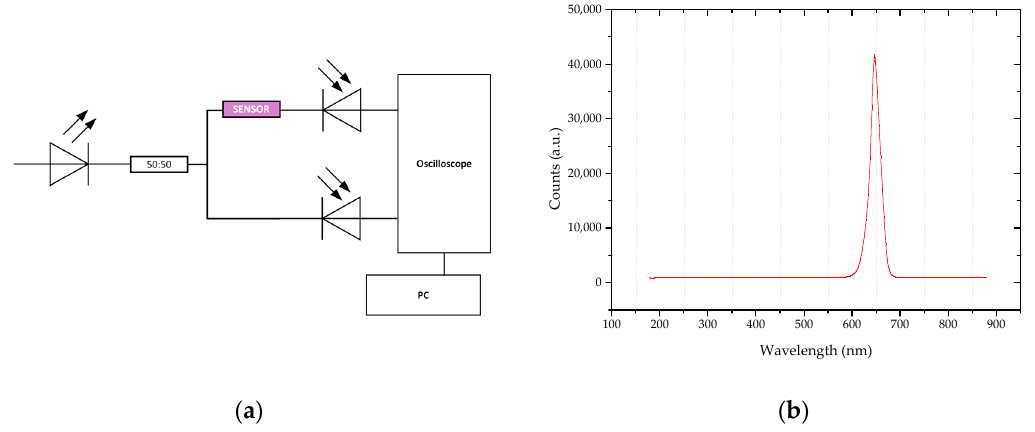
Figure 4. ( a ) Outline of the experimental setup; ( b ) LED spectrum.